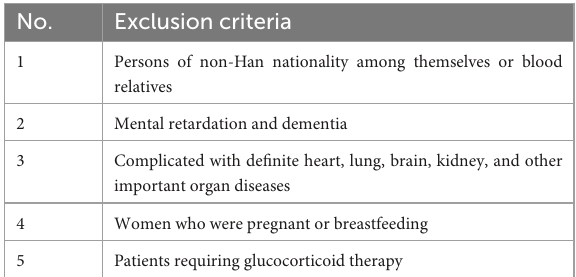
TABLE 2 Exclusion criteria for patients with